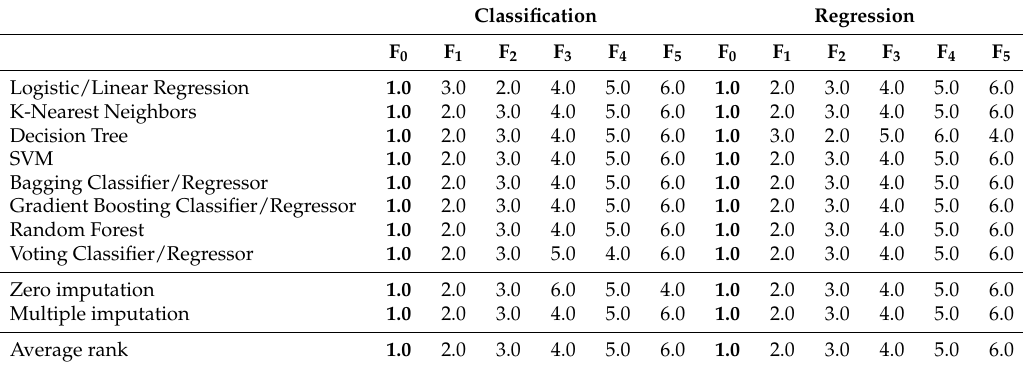
Table 13. Rankings of feature sets for different classification and regression models for